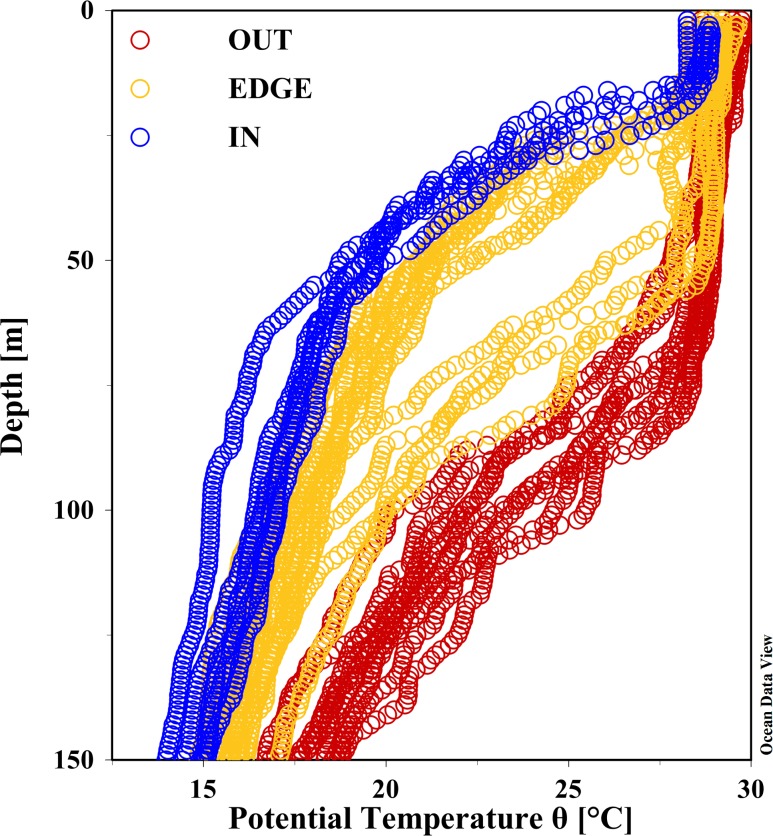
The upper 150 m profiles of potential temperature (°C) for the survey stations to distinguish the three blocks of the C2 (IN, EDGE and OUT).